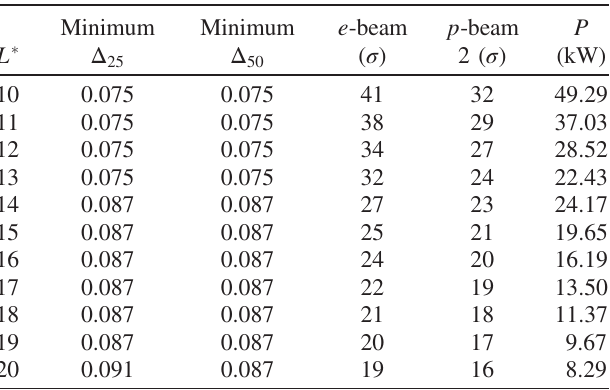
TABLE II. Minimum separation between beams ( Δ ) corre- sponding to each L (cid:1) and bunch spacing. The number of sigmas that can be fitted inside the corresponding aperture for the electron and proton beam is also shown, along with the synchrotron radiation power it